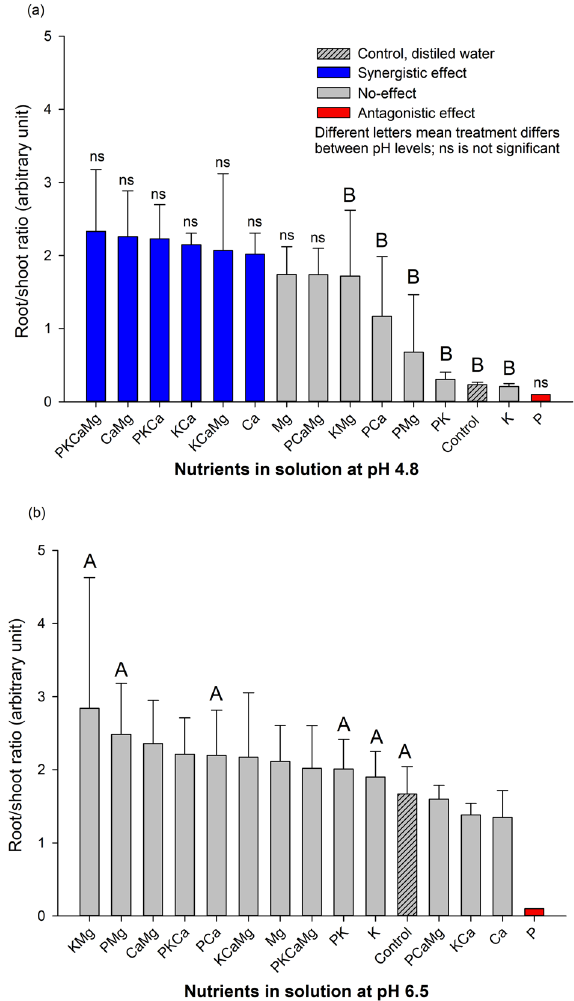
Figure 5. Root:seedling ratio (RSR) of Conyza canadensis in response to the nutrients (alone or in combination) under solutions at pH 4.8 ( a ) and at pH 6.5 ( b ). Bars with the different colours, comparing means among treatments, are significantly different, according to the Tukey’ test ( p < 0.05). Different letters represent a statistical difference for the same treatment between the two pH tested while ns represents not significant; The results in the Bars represent means, while error bar marks represent standard deviation ( n = 4) from the mean